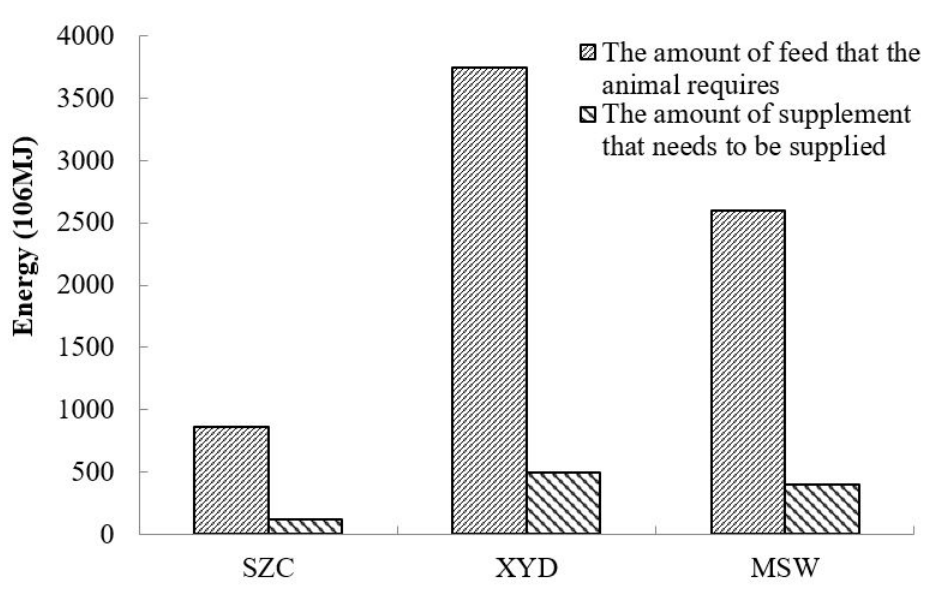
Figure 4. Feed demand compared to supplemental feed in the research